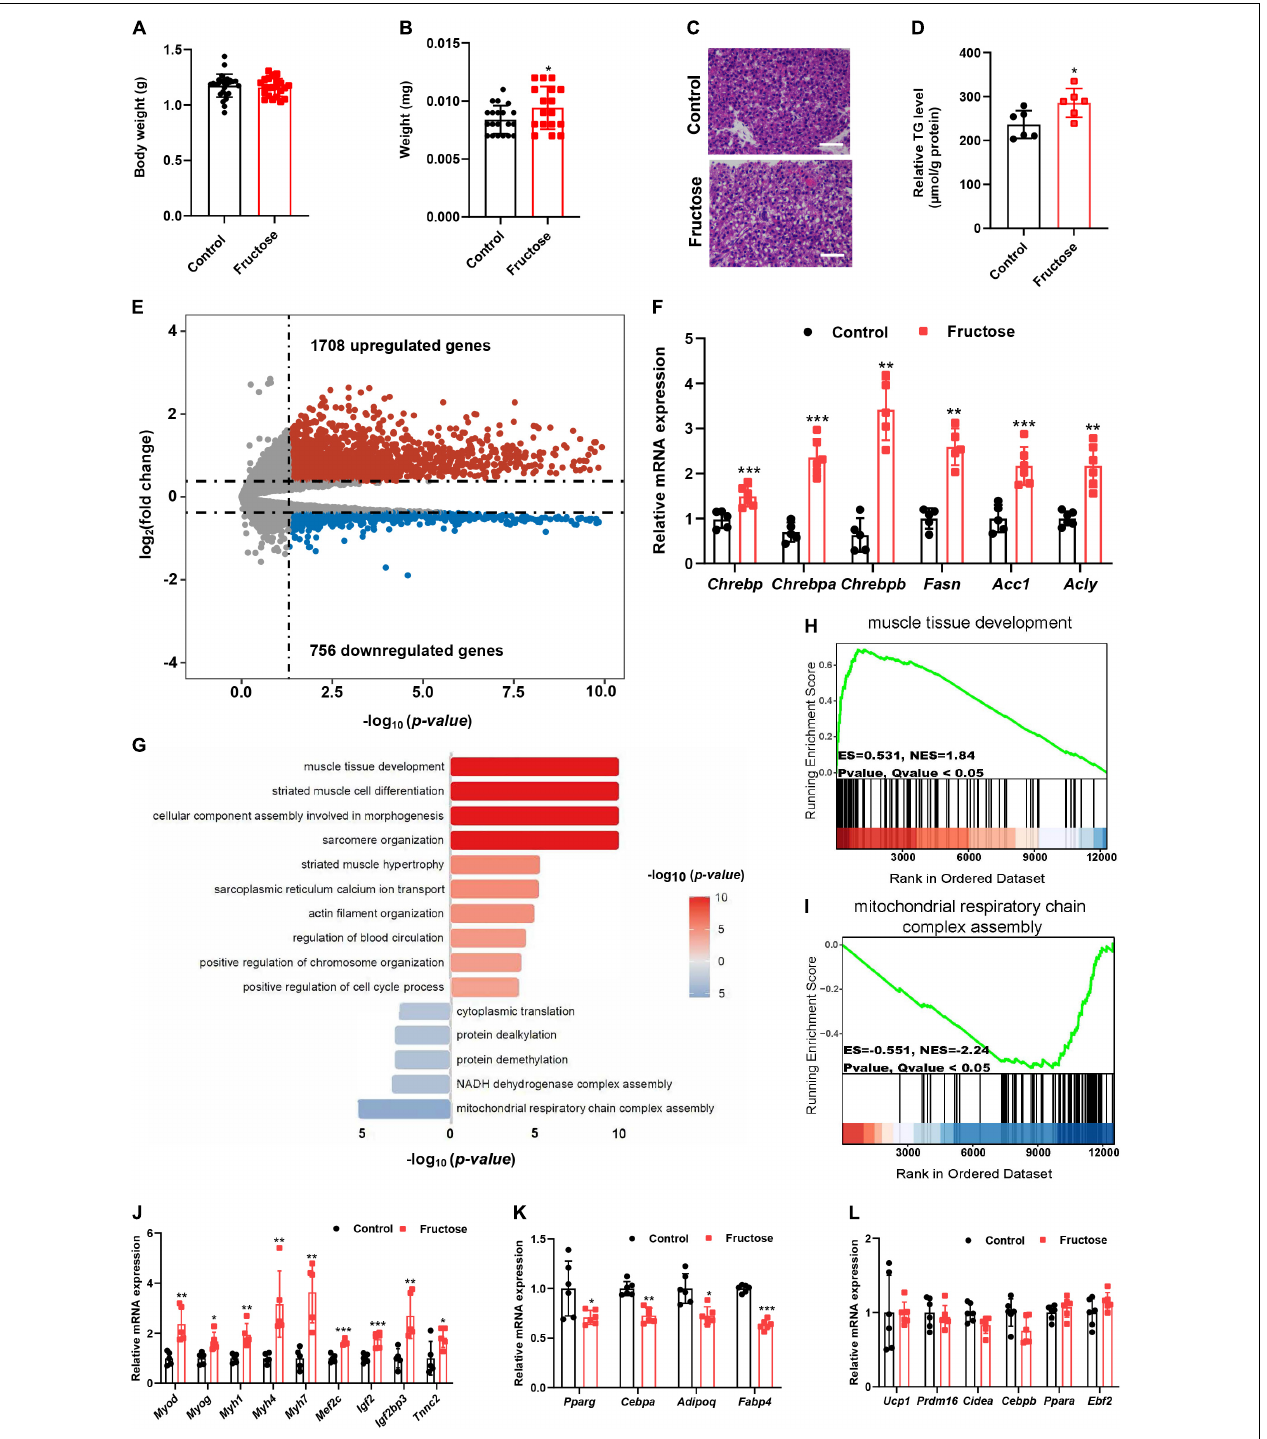
FIGURE 5 | Maternal high-fructose intake during pregnancy induces a myogenic signature in fetal brown fat. All data were collected from fetuses at E18.5. (A) Bodyweight of fetuses ( n = 22–27). (B) Fetal BAT weight ( n = 17–20). (C) H&E staining of paraffin sections of fetal BAT. Scale bar, 50 µ m. (D) Quantification of triglyceride content in fetal BAT ( n = 6). (E) Volcano plot comparison of genes in fetal BAT regulated by maternal high-fructose versus the control ( n = 2 per group). (F) qRT-PCR analysis the levels of Chrebp and its target genes in fetal BAT ( n = 5–6). (G) Gene Set Enrichment Analysis (GSEA) of differentially expressed genes. (H,I) GSEA analysis of the most significant upregulated and downregulated pathways. (J–L) qRT-PCR analysis of myogenic genes, pan-adipocyte genes, and brown fat selective genes in fetal BAT ( n = 5–6). * p < 0.05, ** p < 0.01, *** p < 0.001.